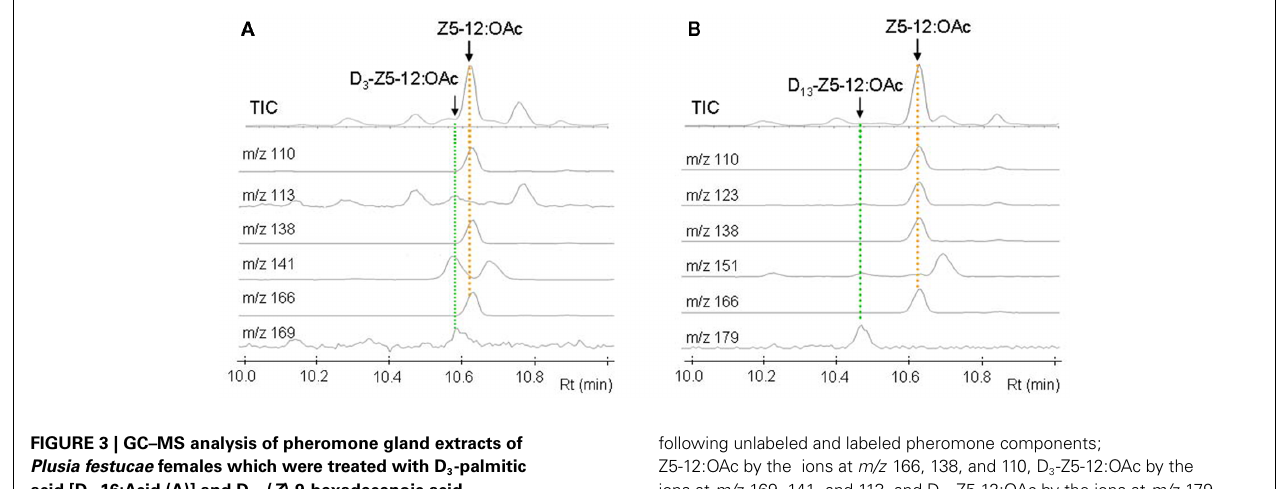
following unlabeled and labeled pheromone components; Z5-12:OAc by the ions at m/z 166, 138, and 110, D 3 -Z5-12:OAc by the ions at m/z 169, 141, and 113, and D 13 -Z5-12:OAc by the ions at m/z 179, 151, and 123.